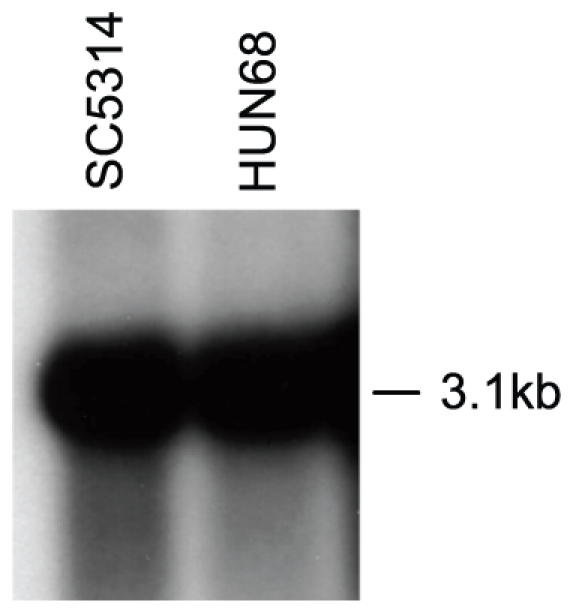
Verification of PNG2 expression by Northern hybridization.Messenger RNA (5 µg per lane) prepared from exponential phase cultures of SC5314 and HUN68 grown in YPD was hybridized under high-stringency conditions with a probe corresponding to the repeat region.